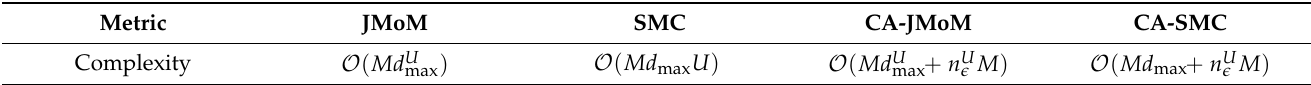
Table 1. Complexity of the proposed